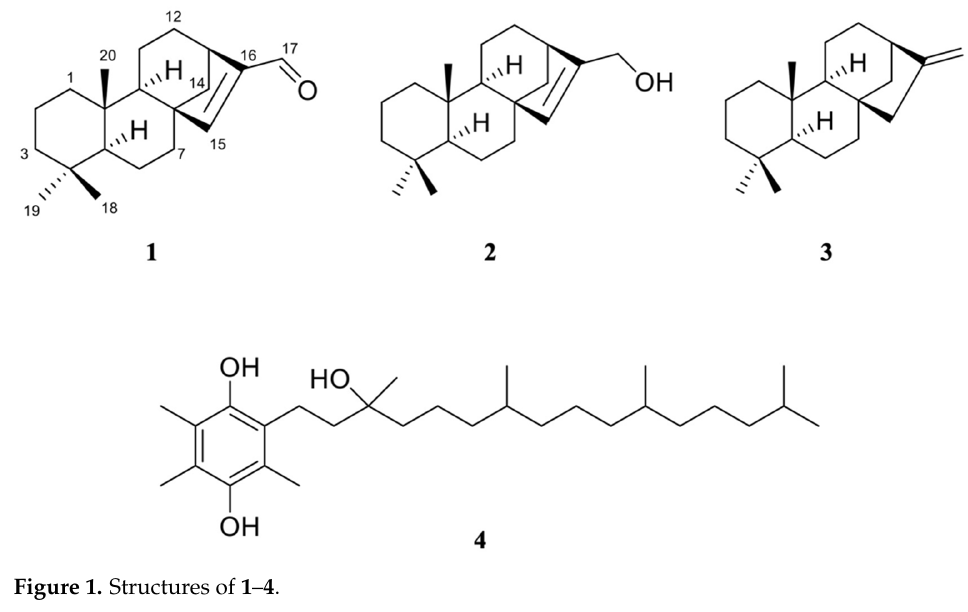
Figure 1. Structures of 1 – 4 .